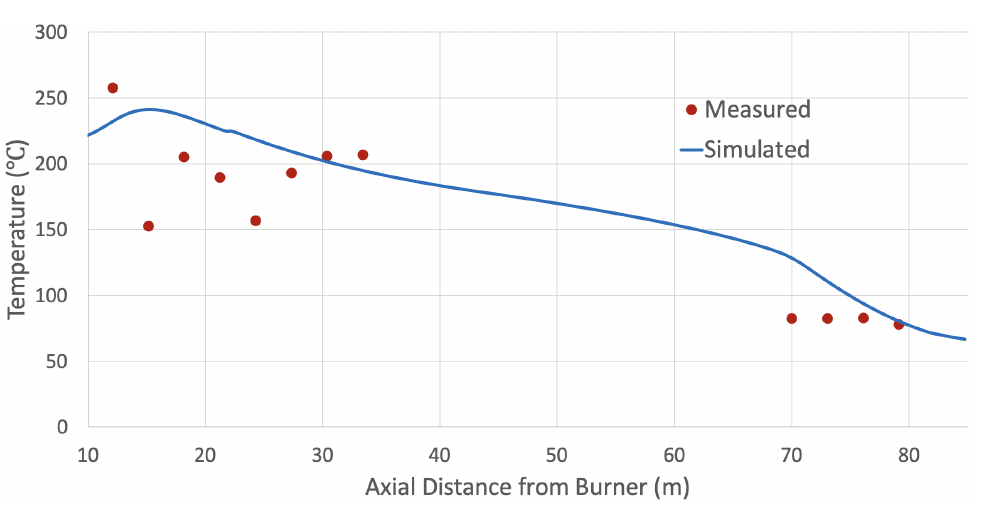
Figure 7. Measured and simulated wet kiln outer shell temperature.